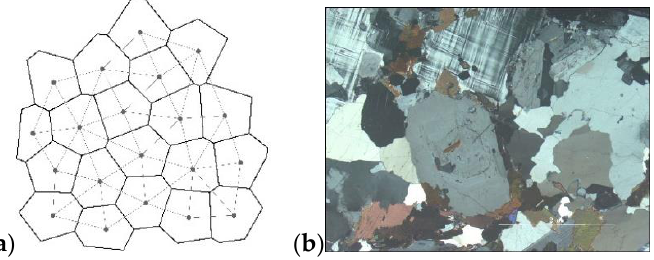
Figure 1. ( a ) Voronoi grain-model ( b ) Natural mineral grain structure in rock.